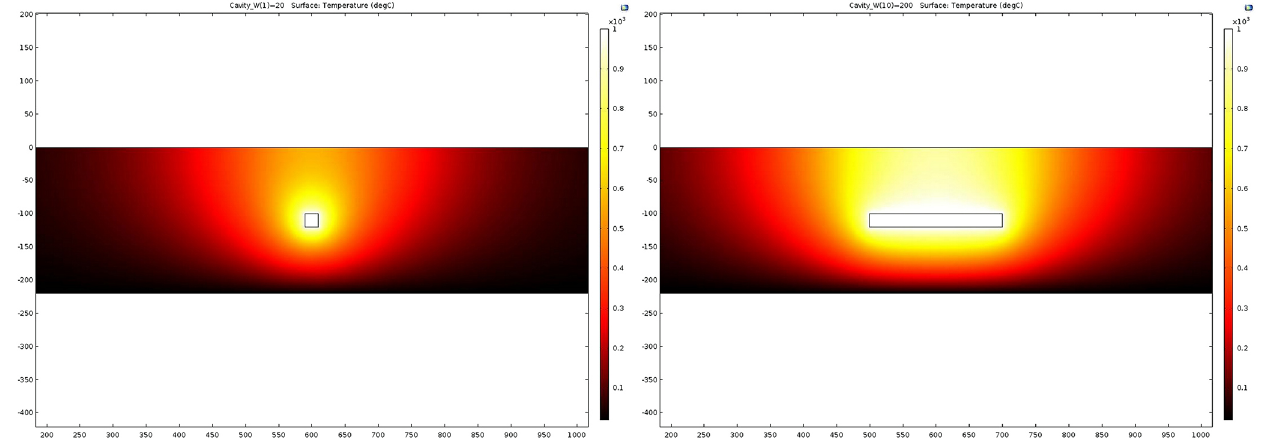
Figure 13. Temperature distribution around a shallow seated cavity.